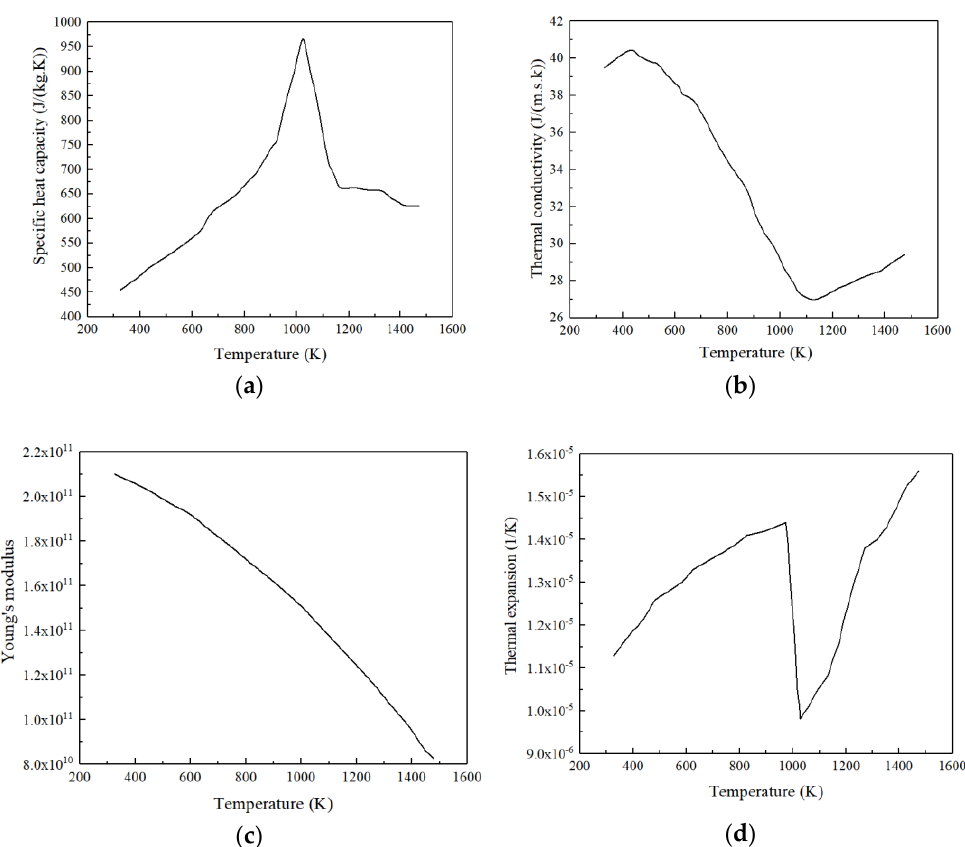
Figure 9. The physical property data of Q345B. ( a ) Specific heat; ( b ) thermal conductivity; ( c ) Young’s modulus; ( d ) thermal expansion coefficient.